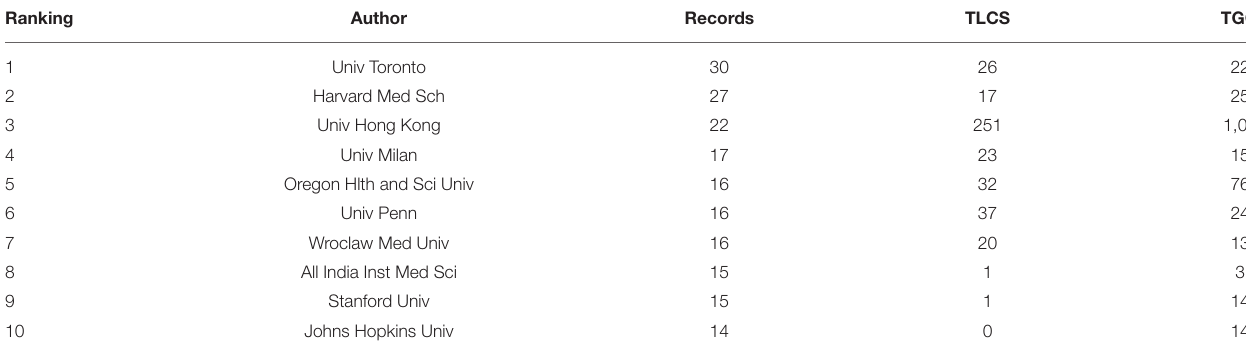
TABLE 6 | Top-10 most prolific institutions in COVID-19 and PPE.